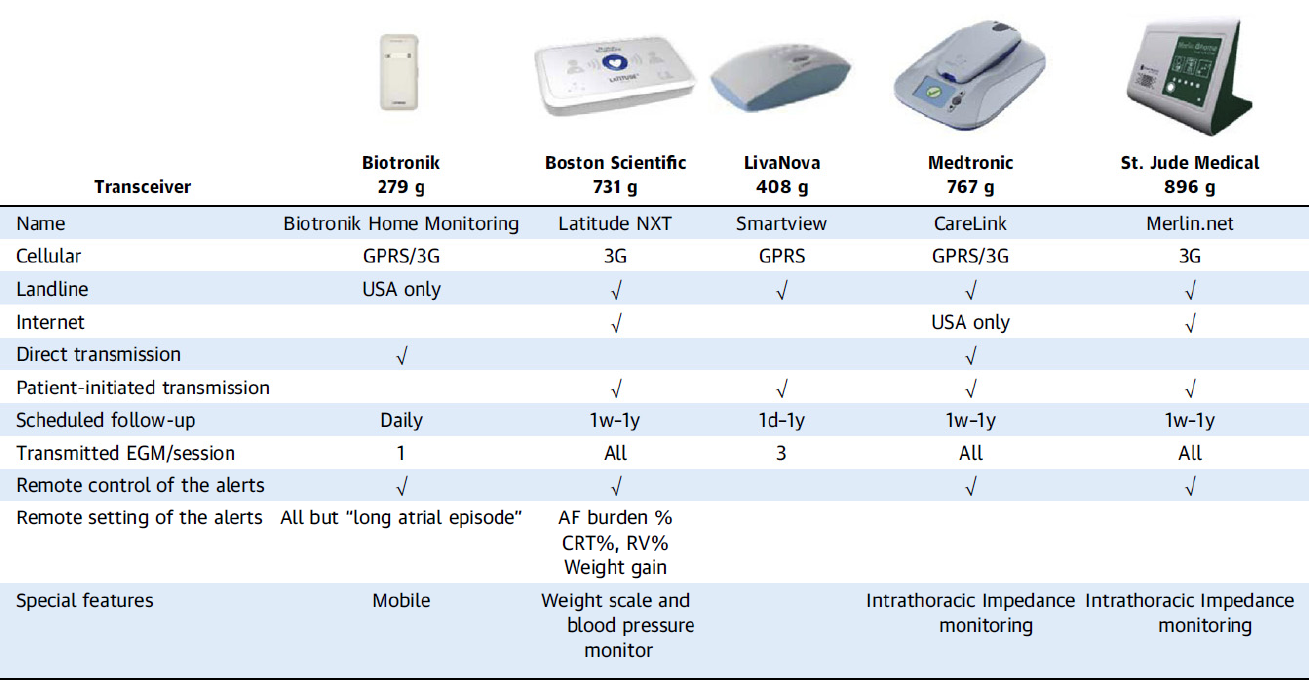
Figure 1. Overview of remote monitoring systems. Reproduced with permission from Ploux et al. (J Am Coll Cardiol EP, 2018) [5].